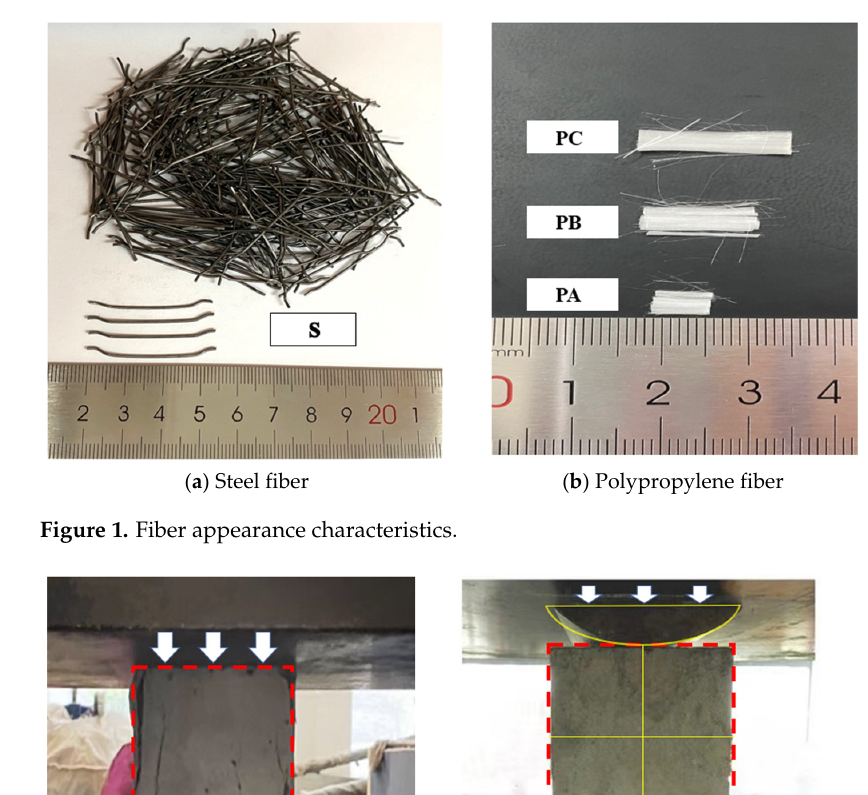
Figure 2. Static mechanical performance test: ( a ) Cube compression test; ( b ) cube split test.